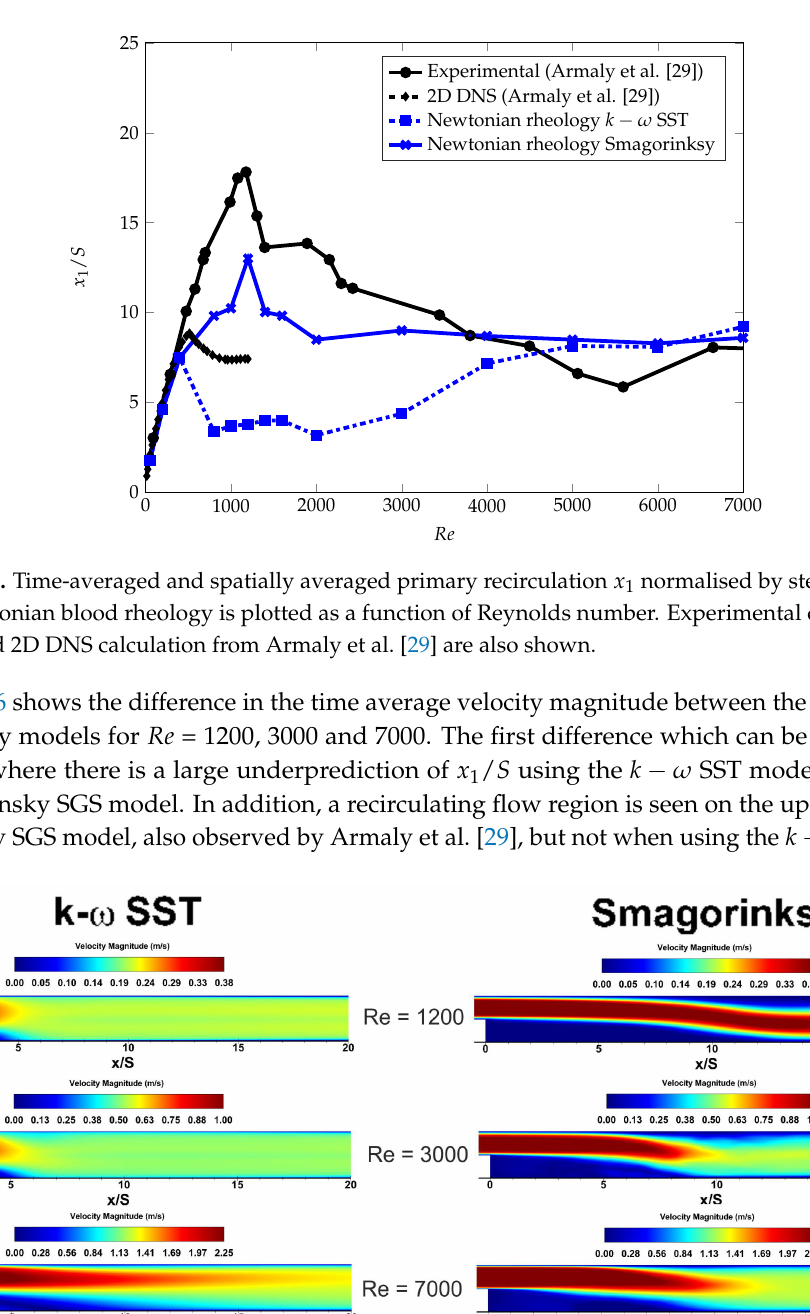
Figure 6. Time-averaged velocity magnitude contours for the k ( b ) for Re = 1200, Re = 3000 and Re =